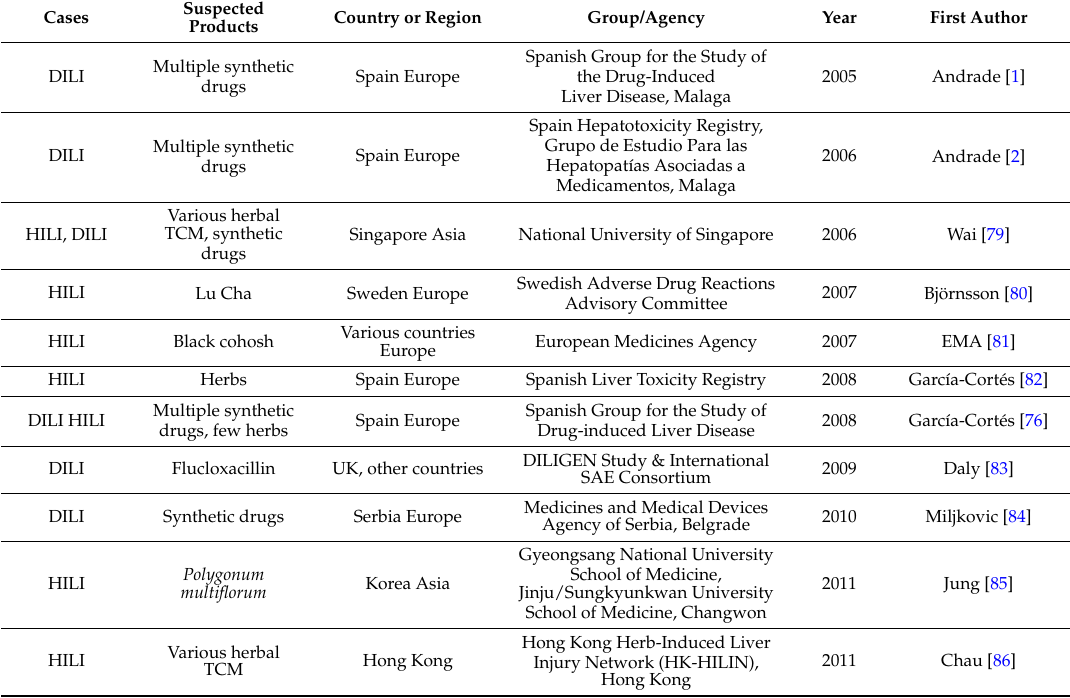
Table 7. Listing of selected international registries and regulatory agencies, and associated groups that applied RUCAM in suspected DILI and HILI